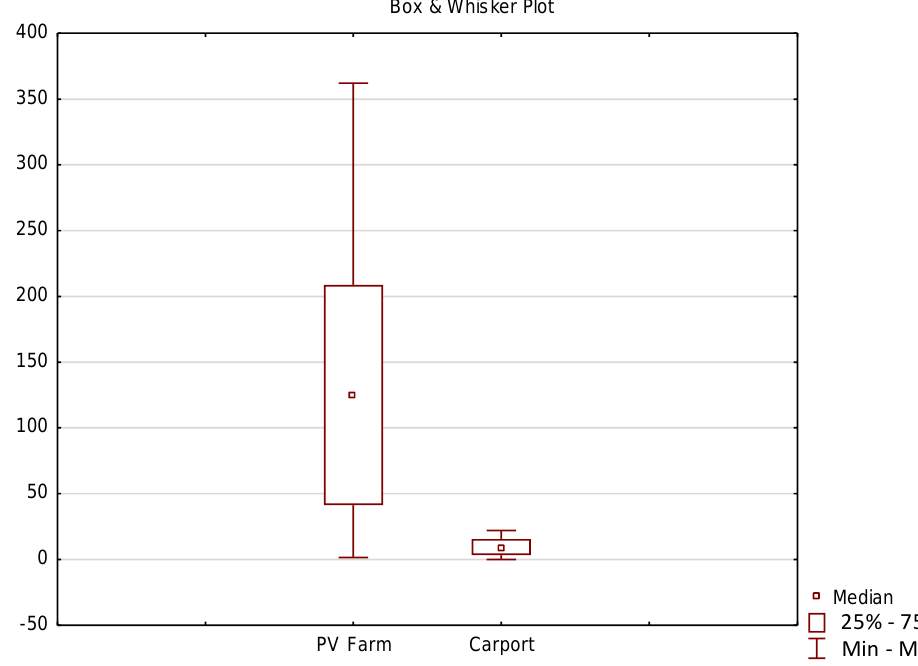
Figure 13. D box plots of the PV farm vs. the carport.